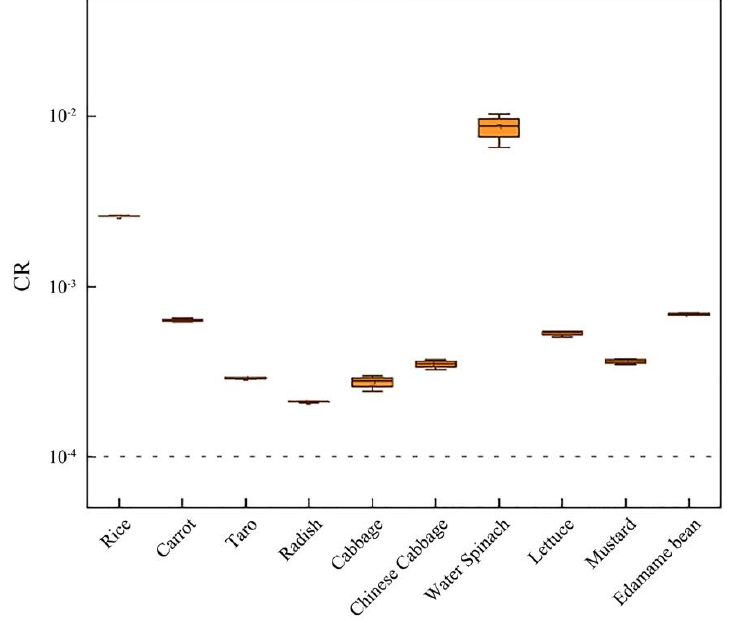
Figure 1. The carcinogenic risk (CR) of Cr associated with different crops. The dotted line indicates the limit value of high carcinogenic risk value.